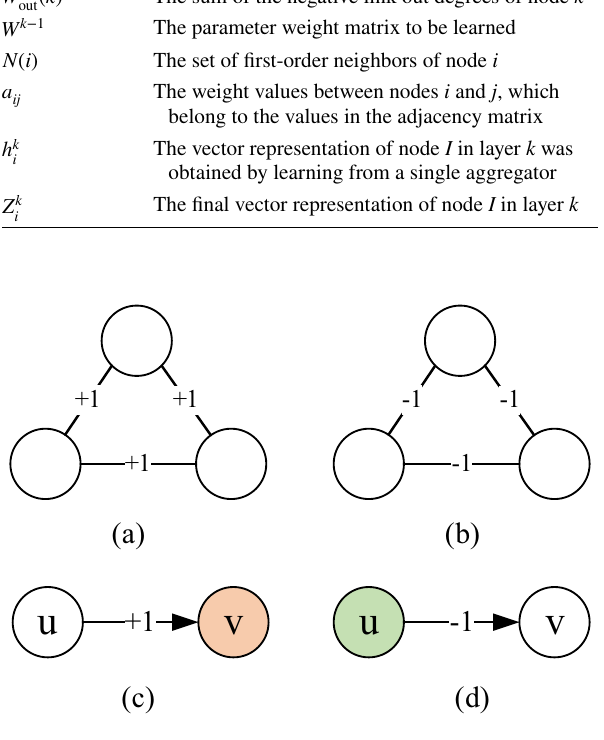
Fig. 2 Two sociological theories in signed